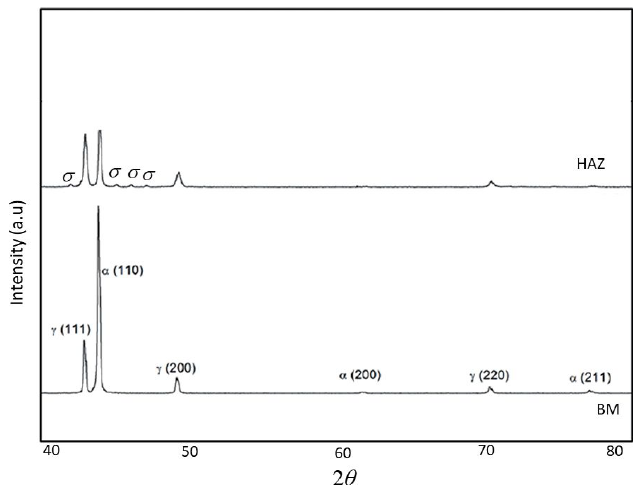
Figure 7. Comparison of the XRD pattern of HAZ with an interpass temperature of 400 o C with the base metal, BM. Table 5. The sigma phase’s maximum volume fraction and reformed austenite and the grain sizes predicted for welding conditions of this study 26,27 .